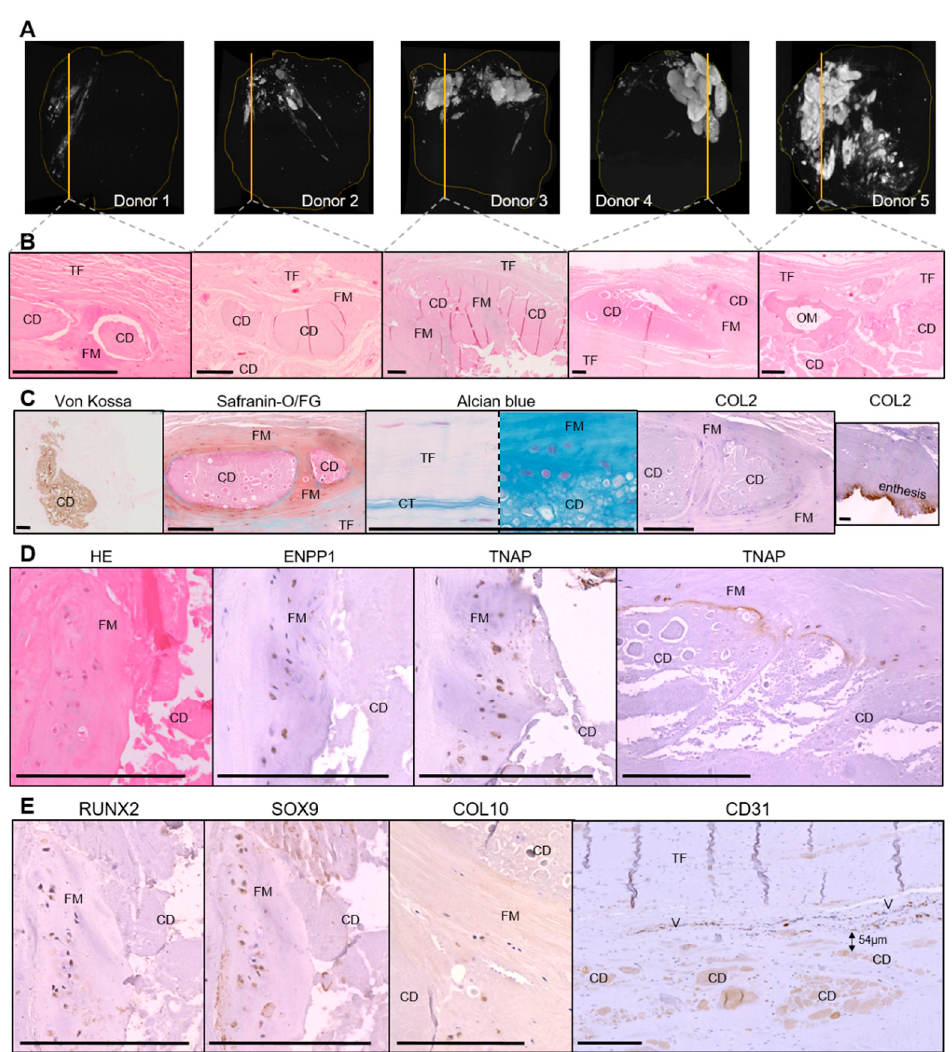
Figure 1. Histological characterization of rotator cuff calcifications ( N = 5). ( A ) Calcific deposits assessed by micro-computed tomography. ( B ) HE (hematoxylin and eosin) staining of decalcified samples (1 image for each patient). ( C ) Von Kossa staining on not decalcified samples and characterization of the fibrocartilaginous area with alcian blue staining, SOFG (Safranin O/Fast Green) staining, and immunohistochemical staining for COL2 (brown) with Gill hematoxylin counterstain. ( D , E ) Representative immunohistochemical staining for ENPP1 (ectonucleotide pyrophosphatase/phosphodiesterase 1), TNAP (tissue non-specific alkaline phosphatase), Runx2, Sox9, Col10 and CD31 (brown). TF: tendon fibers; CD: calcium deposits, FM: fibrocartilaginous